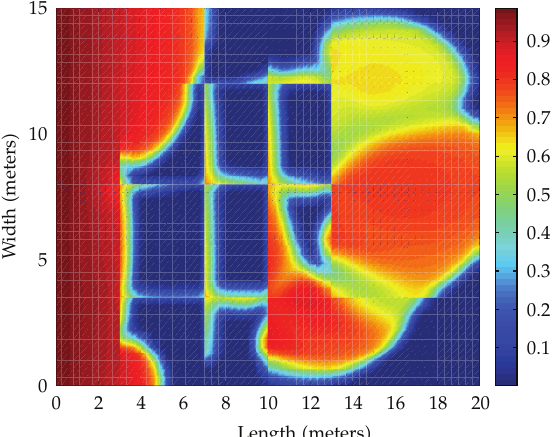
Figure 11: Water saturation profile at 0.5 PVI by the conventional method: Example 4.